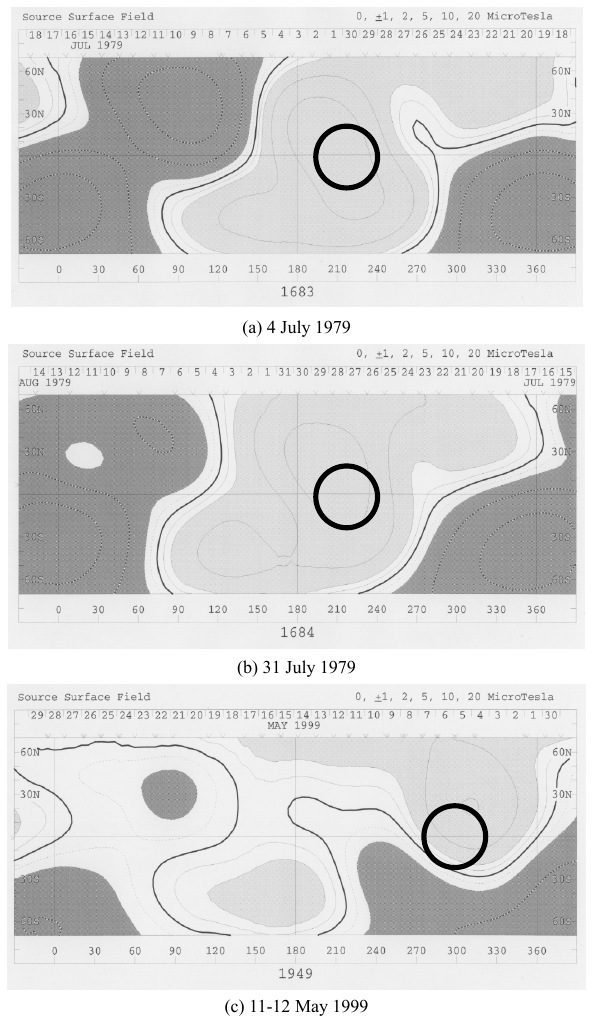
Fig. 8. Synoptic maps of source surface field made by the Wilcox Observatory. Circles show the probable source regions of three long-duration low-density solar wind events shown in Fig. 7.